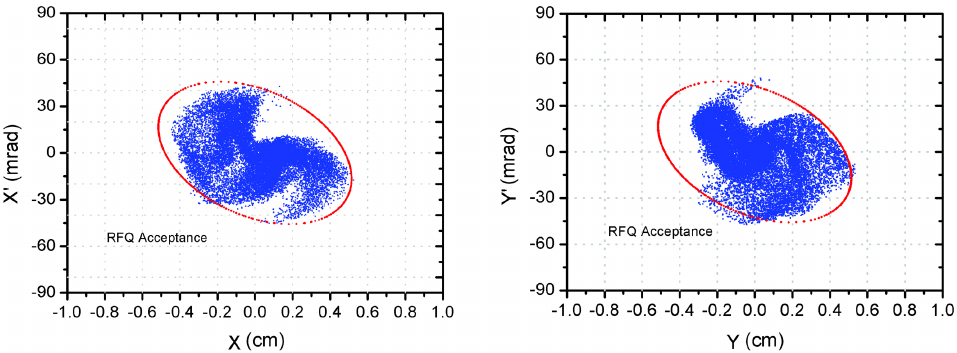
FIG. 21. Simulated particle distributions at the RFQ entrance with collimator